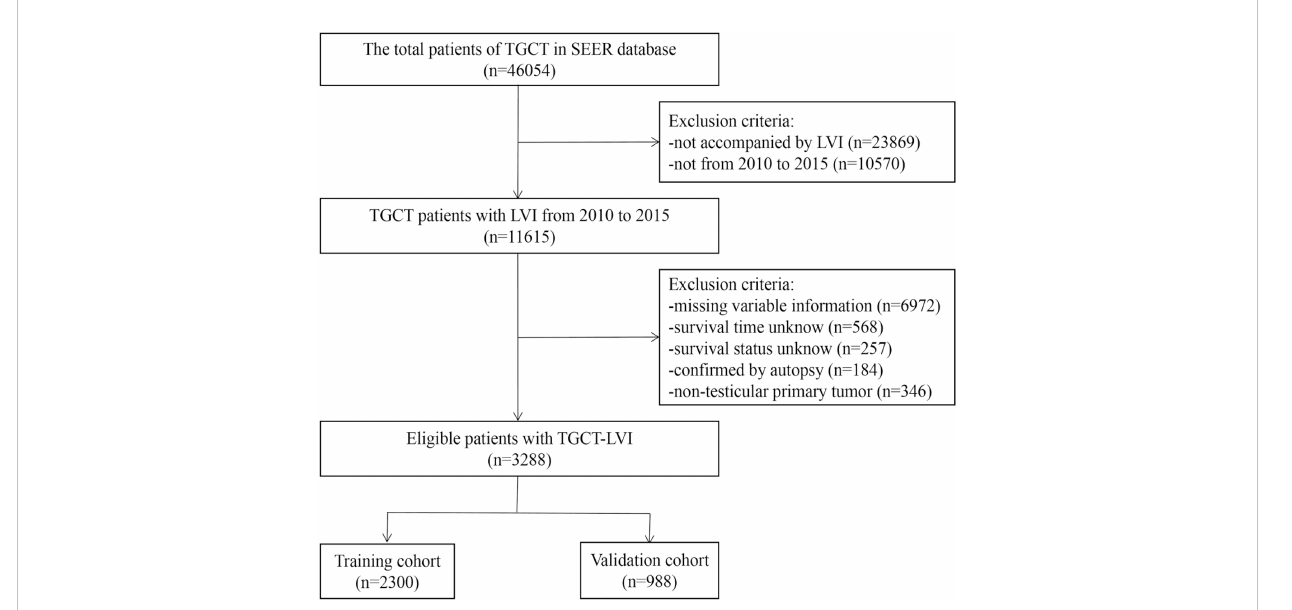
FIGURE 1 The screening process for the data of TGCT patients from the SEER